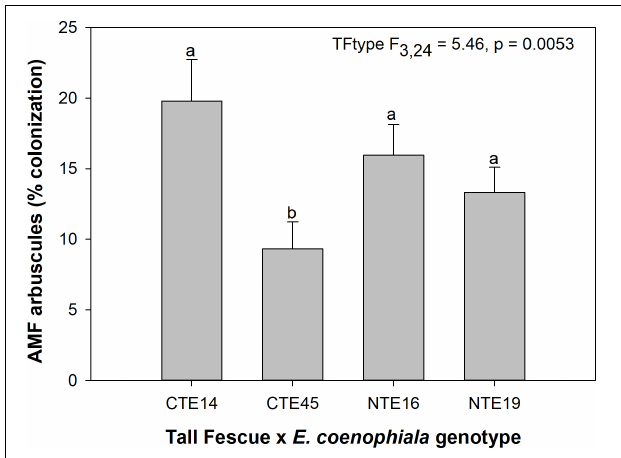
FIGURE 1 | Main effect of tall fescue symbiotic genotype (TFtype) on arbuscule presence in tall fescue roots. Values are means ± 1 SE, and values with different letters are significantly different ( α < 0.05).